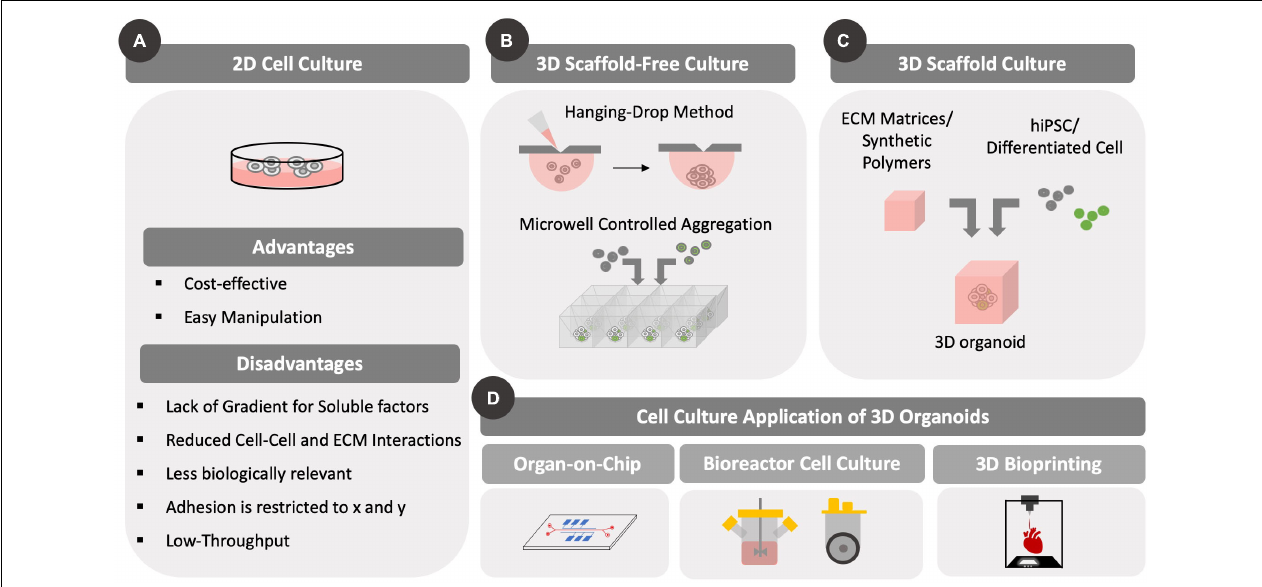
FIGURE 1 | Different types of cell culture formats. Differences between 2D and 3D cell culture methods are highlighted. Importantly, 3D cell culture formats have been developed to accommodate static and/or dynamic (with fluid flow/mixing) designs. The development of 3D culture methods has been prompted by scaffold-based and scaffold-free approaches that can be used for various culture methods, including microfluidic bioreactors and bioprinting. (A) Conventional 2D cell culture formats are illustrated along with advantages and disadvantages. Cells grow as a 2D monolayer with cell–cell contacts across a single surface. (B) Several scaffold-free approaches are highlighted including hanging drop and controlled aggregation methods that use gravity to assemble cells in 3D. (C) Scaffold based approaches include encapsulation of cells in synthetic or natural matrices that provide support to the cells and allow them to remain suspended. (D) The two methods of 3D cell culture have been adapted to both perfusion and static cultures in the form of microfluidic organ-on-chip platform/bioreactor platforms or as bioprinting on a surface, respectively.